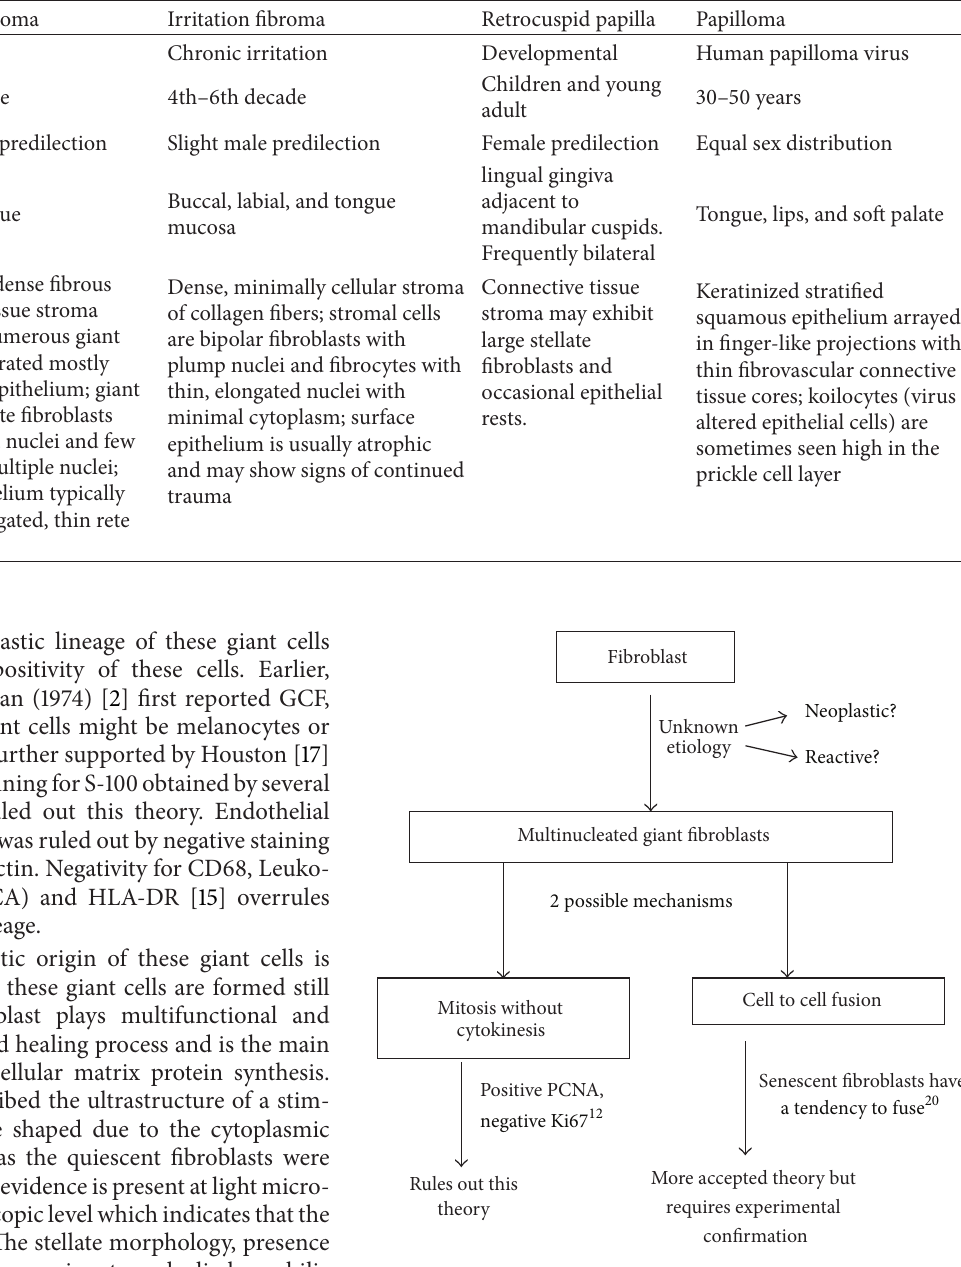
Figure 4: Schematic reprsentation showing possible histogenetic mechanisms for giant